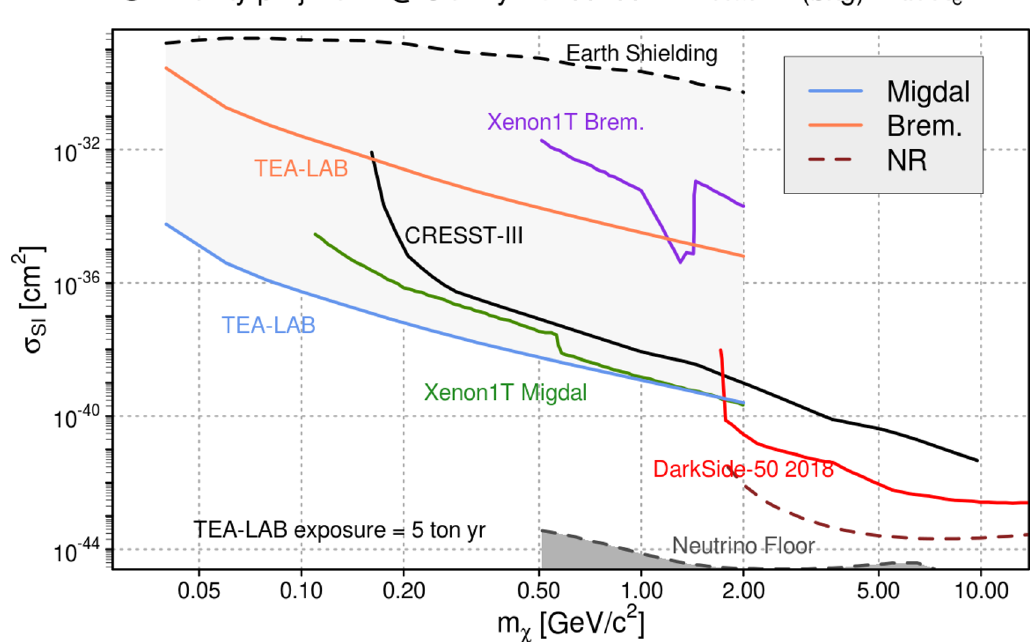
Figure 13 . 90% C : I : upper bounds on the (cid:27) SI exploiting the Migdal electron and photon Bremsstrahlung signals for the tea-lab simulated experiment loosely inspired by DarkSide-50. These results are obtained using and exposure E = 5 ton yr , and simulating a pseudo-dataset with the background-only template, not including the LowNe excess (see section 3.2, 3.1). The tea- lab bounds are computed for a threshold N = 4 . The estimate of the Earth shielding effect e (cid:0) for tea-lab is also reported (black dashed curve). The gray shaded area, has to be intended as the region where tea-lab has the sensitivity to exclude a DM signal exploiting the Migdal elec- tron. For m (cid:31) < 0 : 04 GeV we completely loose sensitivity because the signal template is always under threshold. The upper limits of the Xenon1T [49], CRESST [40], and DarkSide-50 [29] are reported. We report also our calculation for the DarkSide-50 bounds on NR signal extrapolated at E = 5 ton yr (brown dashed line). The neutrino floor for LAr experiments [29] is reported as a dark-gray shaded